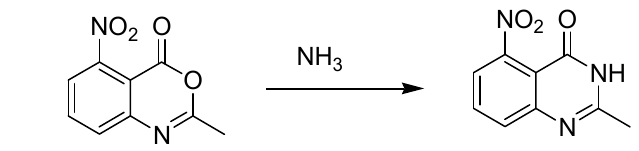
Figure 4. Synthesis of quinazolin-4(3H)-one. (v) Synthesis of quinazoline-2,4(1H,3H)-dione: Anthranilic acid and potassium cyanate